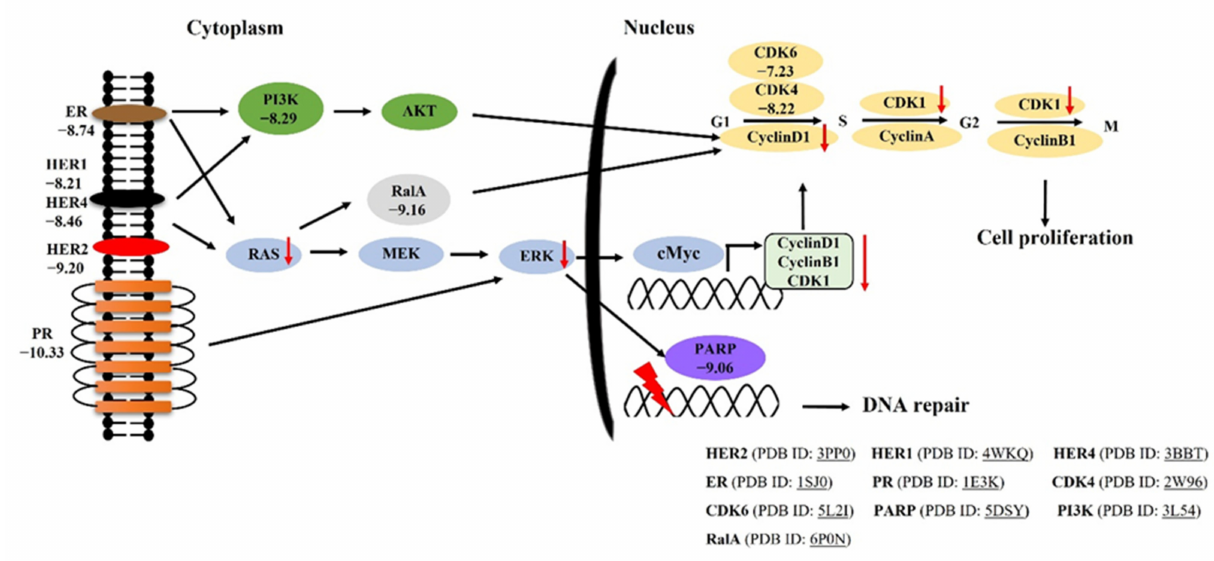
Figure 8. The proposed pathway of trans-( − )-kusunokinin binds HER2 protein on breast cancer cells. A number denotes the binding energy in kcal/mol from molecular docking analysis. The red arrow refers to the decreasing of proteins on MCF-7 cells by trans-( − )-kusunokinin. The PDB identification code of each protein is shown as the underlined